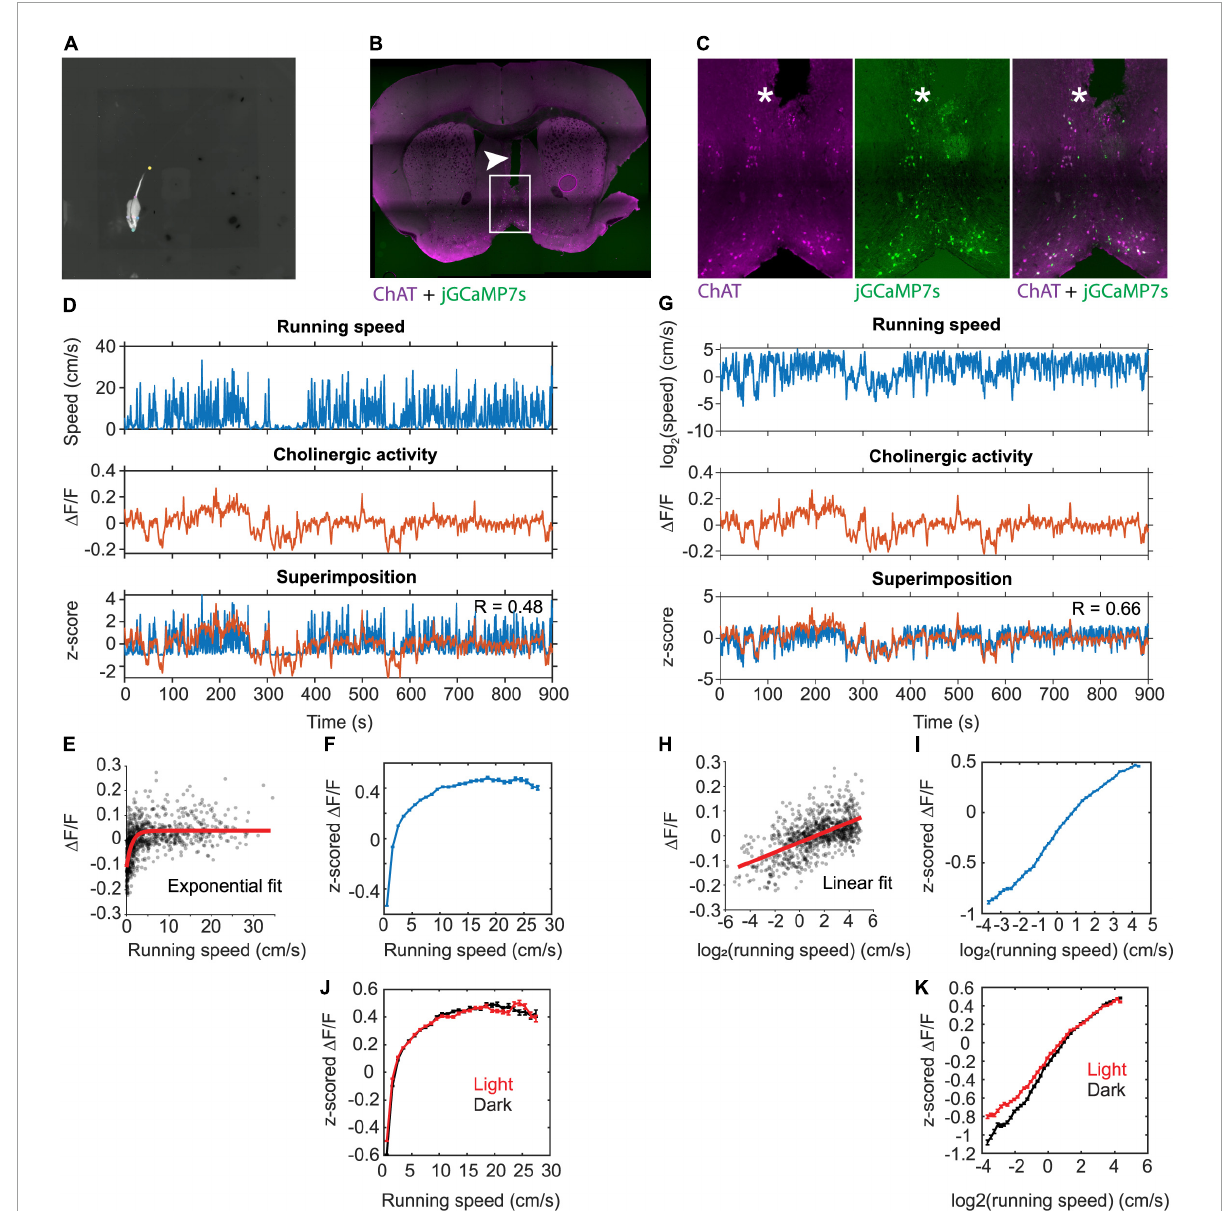
FIGURE1 Linear correlation between the population activity of MSDB cholinergic neurons and the logarithm of an animal’s running speed. (A) One video frame showing the DeepLabCut labels for neck, nose, left ear, right ear, tail base, and tail tip. Gray scale of the video shows the temperature of the mouse recorded via a thermal camera. (B) Histological verification of the fiber track position in the MSDB. The arrowhead marks the fiber track. Magenta colors indicate immune-positive staining for ChAT, green colors indicate presence of jGCaMP7s. (C) Immuno-histological data on jGCaMP7s expression in the MSDB neurons. Note the overlap between jGCaMP7s-postive and ChAT-positive neurons. The asterisk marks the tip of the implanted optical fiber. (D) Data on running speed and activity of cholinergic neurons in the MSDB measured via fiber-photometry for one example session. Note the high fluctuations in the fiber photometry signal during low running speeds. (E) Scatter plot of cholinergic activity vs. running speed; data points were sampled in 1-s intervals from the time series data shown in (D). Red line shows the exponential fit to the data. (F) Speed tuning curve of cholinergic activity. Data show mean ± s.e.m. of speed-binned data with a bin width of 1-cm/s; data from 103 sessions recorded from 5 mice. (G) Same data as in (D) but now plotting the logarithm of running speed. (H) Scatter plot of cholinergic activity vs. the logarithm of the animal’s running speed; data points were sampled in 1-s intervals from the time series data shown in (G). Red line shows the linear fit to the data. (I) Tuning curve shows cholinergic activity as a function of the logarithm of running speed; data show mean ± s.e.m. of binned data with a bin width of 0.1; data from 103 sessions recorded from 5 mice; (J) Speed tuning curves of cholinergic activity comparing data from light (red, n = 55) and darkness (black, n = 47) sessions; data presented as in (F) (K) data presented as in (I) comparing data from light (red, n = 55) and darkness (black, n = 47) sessions; no significant difference between light and darkness sessions was found (see Table 2 for statistics). R, Pearson’s correlation